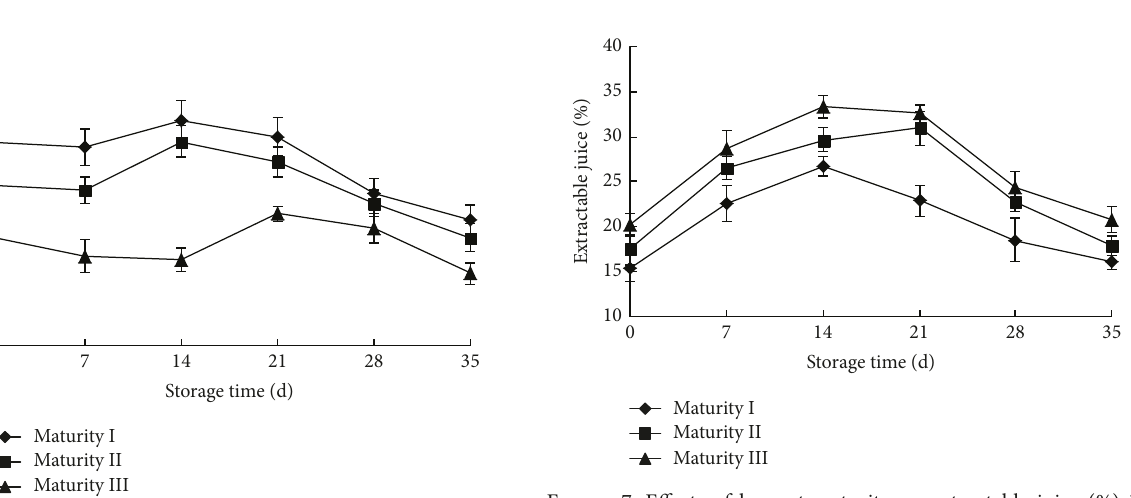
Figure 4: Effects of harvest maturity on soluble solid content in apricots; fruits with maturity class I (colored area < 50%), maturity class II (colored area 50–80%), and maturity class III (colored area > 80%) were categorized according to yellow conversion rate. Vertical bars represent the standard errors of the means of triplicate replicates.